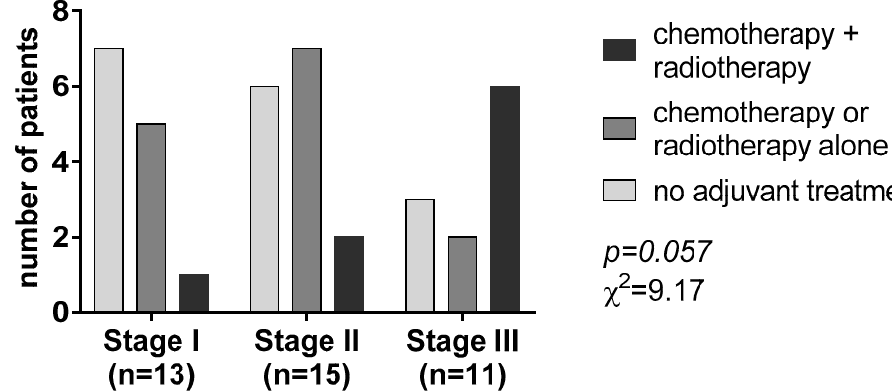
Figure 1. Adjuvant treatment according to the tumor-nodal-metastasis (TNM) staging system. Most patients with stage I disease (53.8%) did not receive any adjuvant treatment. Chemotherapy or radiotherapy alone was the most given adjuvant treatment in patients with stage II disease (46.8%). On the contrary, most patients with tumor stage III (n = 6, 54.5%) received chemotherapy associated with radiotherapy (Figure 1).